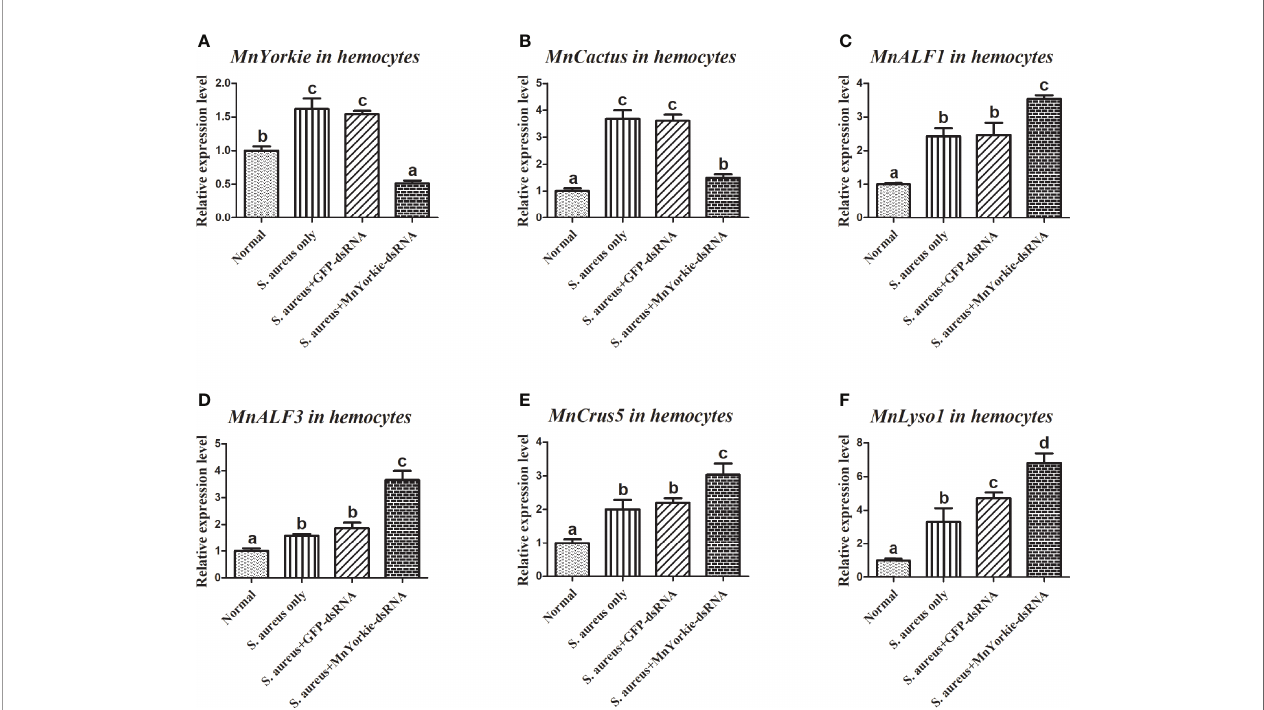
FIGURE 7 | Analysis of MnCactus and four immune-related genes expression levels after MnYorkie RNAi. (A) Ef fi ciency of RNAi detected by RT-qPCR in hemocytes at 36 h post of MnYorkie -dsRNA and S. aureus injection. The mRNA expression levels of MnCactus (B) , MnALF1 (C) , MnALF3 (D) , MnCrus5 (E) , MnLyso1 (F) were analyzed by RT-qPCR at 24 h injection of S. aureus post MnYorkie RNAi. Signi fi cance differences were compared between the normal group to other treated groups at the same time point. Signi fi cant differences were marked with different letters (a, b, c, d).